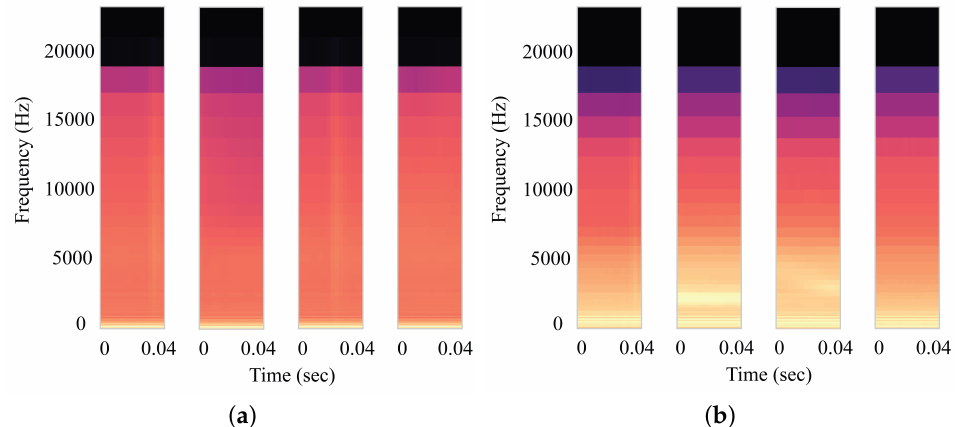
Figure 3. Selected centroid plots identified by spherical k-means showing ( a ) the selected fire centroid plots and ( b ) the selected forest centroid plots.